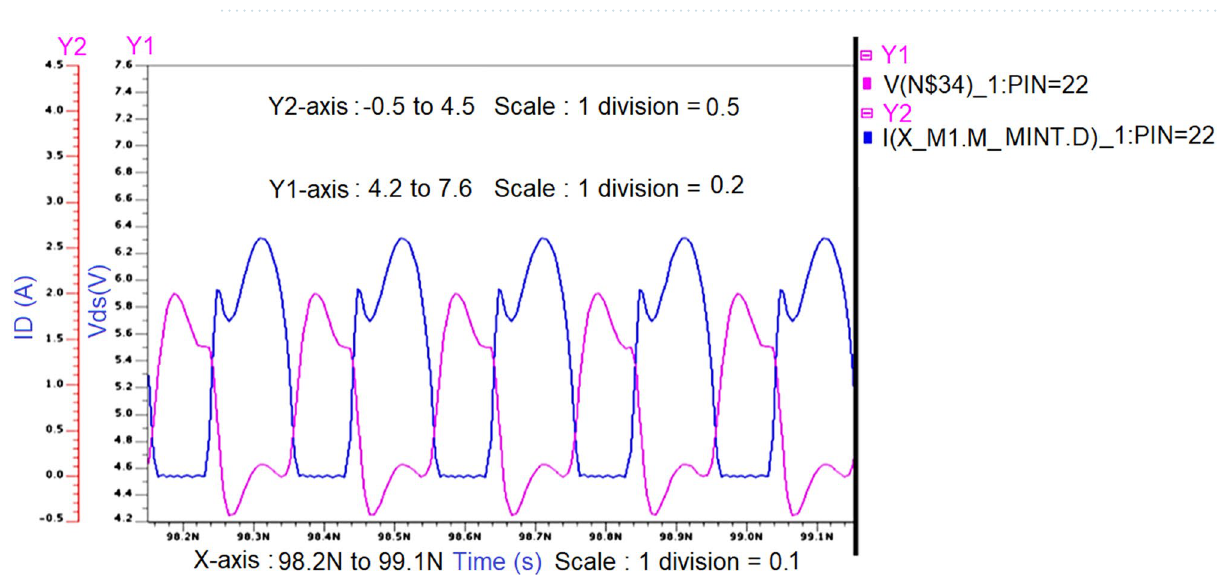
Figure 21. Intrinsic voltage and current waveforms at the drain of Class-J PA (V DS and I D ) with Fourier input source at 5